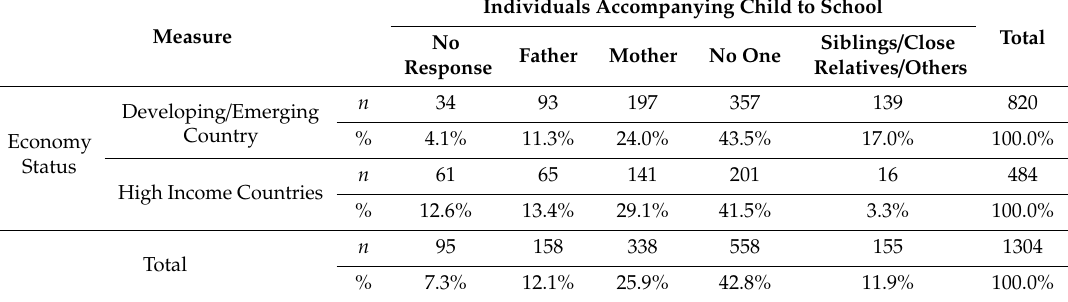
Table 3. Dependent and independent school commuting in high-income countries (Germany, Italy, and the Netherlands) versus emerging / developing countries (Poland, Greece, Turkey, and Croatia) in the sample ( n =